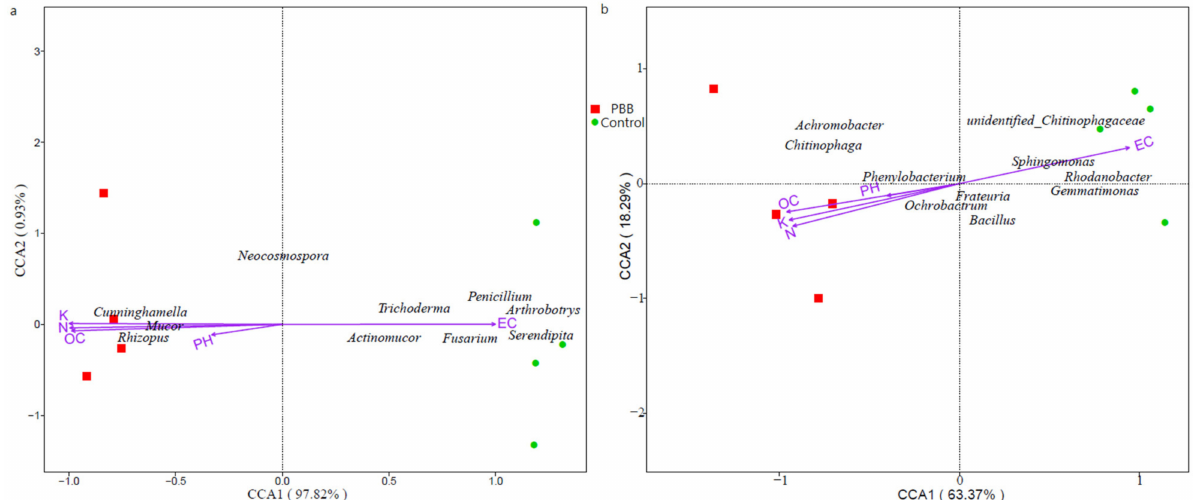
Figure 3. Canonical correspondence analysis (CCA) diagram illustrating the relationship between fungal ( a ) and bacterial ( b ) composition at genus level from different samples and environmental